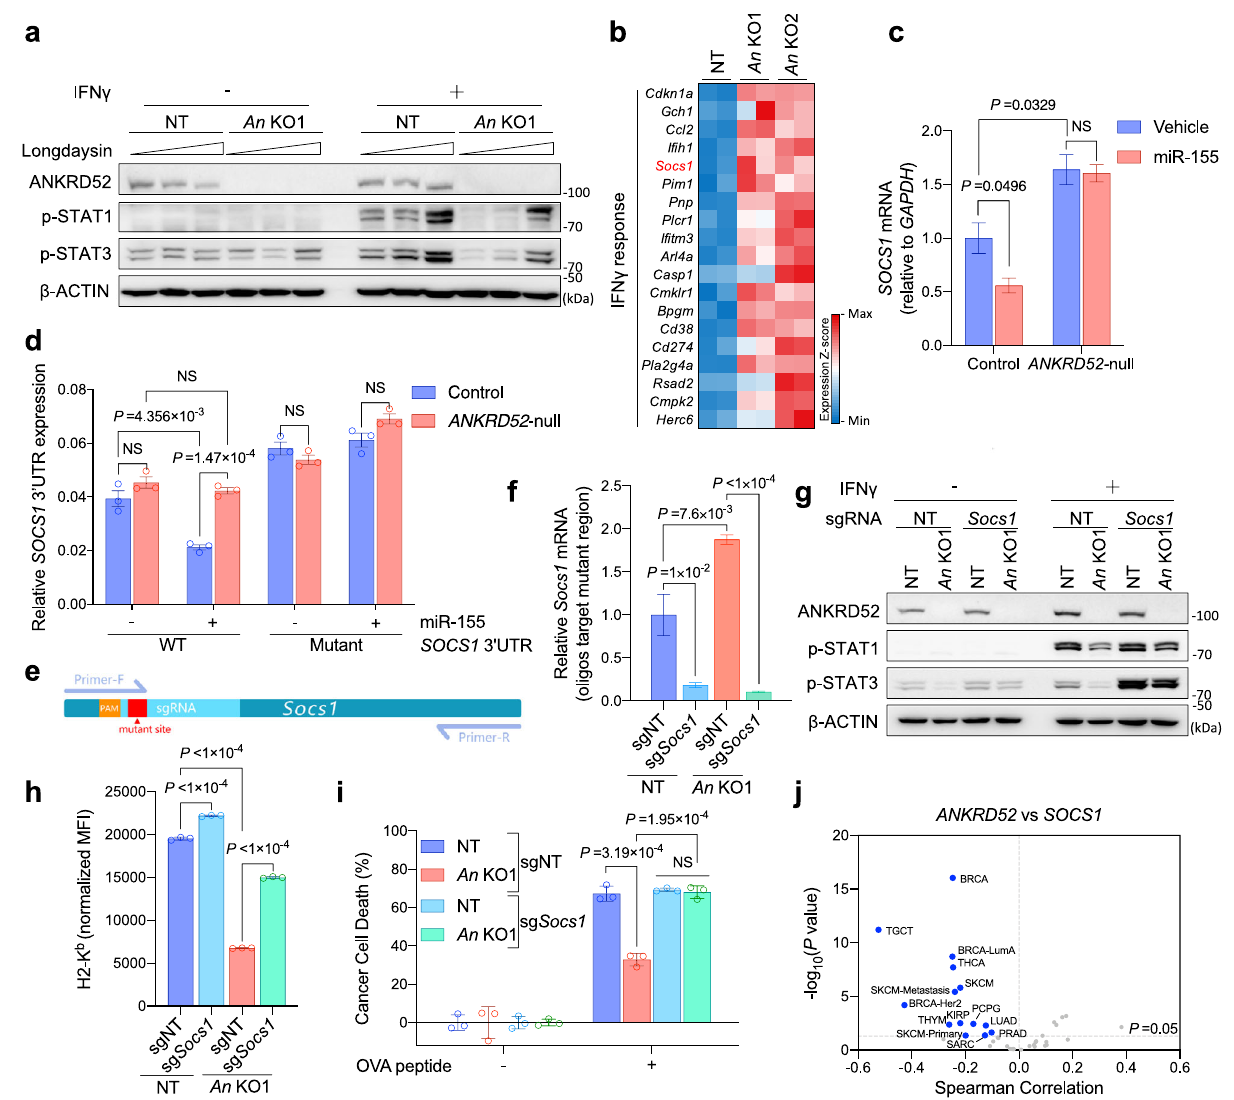
Fig. 6 ANKRD52 is required for miRNA-mediated silencing of SOCS1 to regulate T cell response. a p-STAT1 and p-STAT3 abundance in MC38 cells treated with IFN γ and increasing Longdaysin (0, 50, 100 μ M, a CK1 α inhibitor). Data are representative of three independent experiments. b Heatmap showing commonly upregulated gene expression of IFN γ signaling by RNA-seq analysis of Ankrd52 -null MC38 cells ( n = 2 replicates per group). c SOCS1 mRNA level in control and ANKRD52 -null 293 T cells overexpressing miR-155 ( n = 3 per group per condition). Data are representative of two independent experiments and represented as mean ± s.e.m., signi fi cance was determined using two-tailed unpaired Student ’ s t -test. d Activity of WT and mutant SOCS1 3 ’ UTR (Rluc/Fluc) in a dual-luciferase reporter in 293 T cells overexpressing miR-155 ( n = 3 per group per condition). Data are representative of three independent experiments and represented as mean ± s.e.m., signi fi cance was determined using two-tailed unpaired Student ’ s t -test. e Schematic overview of qPCR test targeting mutant region to check Socs1 knockout ef fi ciency. f Socs1 mRNA level tested by qPCR targeting mutant region in Ankrd52 -null MC38 cells with inactivated SOCS1 ( n = 5 per group). Data are represented as mean ± s.e.m., signi fi cance was determined using two-tailed unpaired Student ’ s t - test. g p-STAT1 and p-STAT3 abundance in Ankrd52 -null MC38 cells with inactivated SOCS1 after IFN γ treatment. Data are representative of three independent experiments. h Membrane MHC-1 expression in Ankrd52 -null MC38 cells with inactivated SOCS1 after IFN γ treatment. MFI of H2-K b was normalized by the responding group without IFN γ treatment ( n = 3 per group per condition). Data are representative of two independent experiments and represented as mean ± s.d., signi fi cance was determined using two-tailed unpaired Student ’ s t -test. i Killing of OVA-treated Ankrd52 -null MC38 cells with inactivated SOCS1 by OT-I T cells ( n = 3 per group per condition). Data are representative of two independent experiments and represented as mean ± s.d., signi fi cance was determined using two-tailed unpaired Student ’ s t -test. j Volcano plot showing the Spearman ’ s correlation and estimated signi fi cance of ANKRD52 with SOCS1 mRNA levels across all TCGA cancer types. Each dot represents a cancer type, blue dots indicate signi fi cant negative correlations ( P < 0.05, TIMER). See also Supplementary Figs. 10 and 11. Source data are provided as a source data fi signi fi cantly upregulated in ANKRD52-de fi cient cells compared signaling and cancer immunotherapy 11,45 , and its mRNA levels to control cells (Fig. 6b; Supplementary Fig. 10b; Supplementary were reciprocally controlled by ANKRD52 and CK1 α (Supple- Data 3), among which SOCS1 was also shown to be similarly mentary Fig. 10d, e). Overexpression of miR-155, the major controlled by ANKRD52 in human colorectal carcinoma HCT116 SOCS1 -targeting miRNA 48 , in 293 T cells led to ANKRD52- dependent repression of SOCS1 mRNA levels (Fig. 6c; cells 21 (Supplementary Fig. 10c). SOCS1 suppresses JAK-STAT